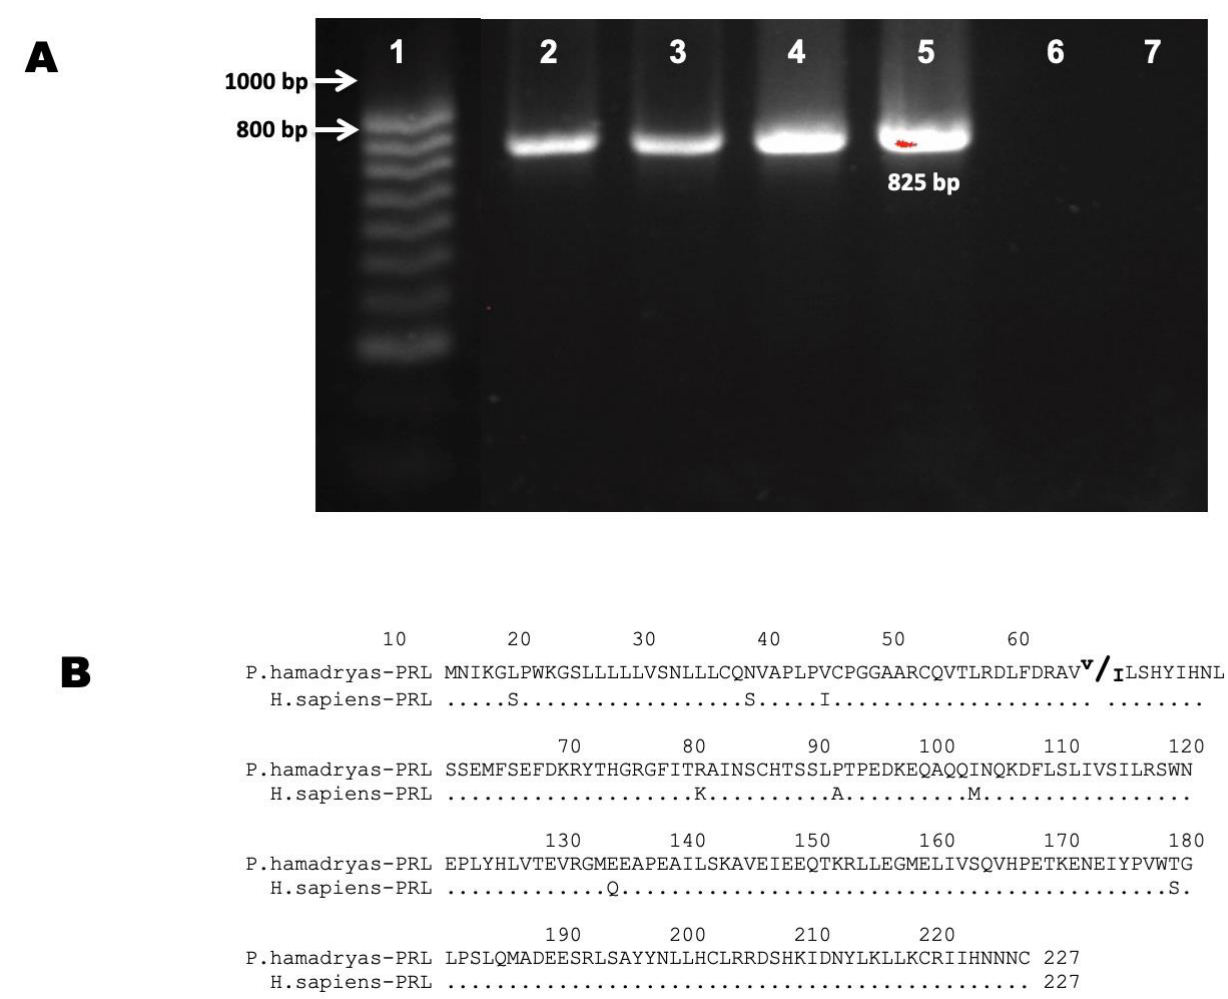
Figure 1. Prolactin transcript’s expression in baboon eye. ( A ) Agarose gel electrophoresis of PCR products obtained with primers for cDNA of PRL generated from different retinal tissues. Lanes: (1) Molecular weight marker, (2) baboon adult retina, (3) baboon fetal retina, (4) baboon fetal pituitary, (5) baboon adult pituitary as a positive control, (6) baboon adult liver as a negative control, and (7) Non-Template Control (NTC). ( B ) Sequence of the PRL predicted from the open reading frame ac- cording to sequenced amplicons and comparison with the human PRL sequence. Table 1. Tissue distribution of PRL mRNAs and proteins in baboon eye.